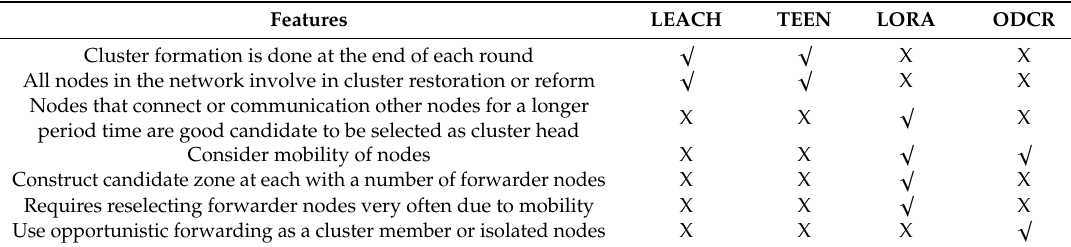
Table 2. Comparison of the proposed opportunistic density cluster-based routing protocol (ODCR) protocol with existing